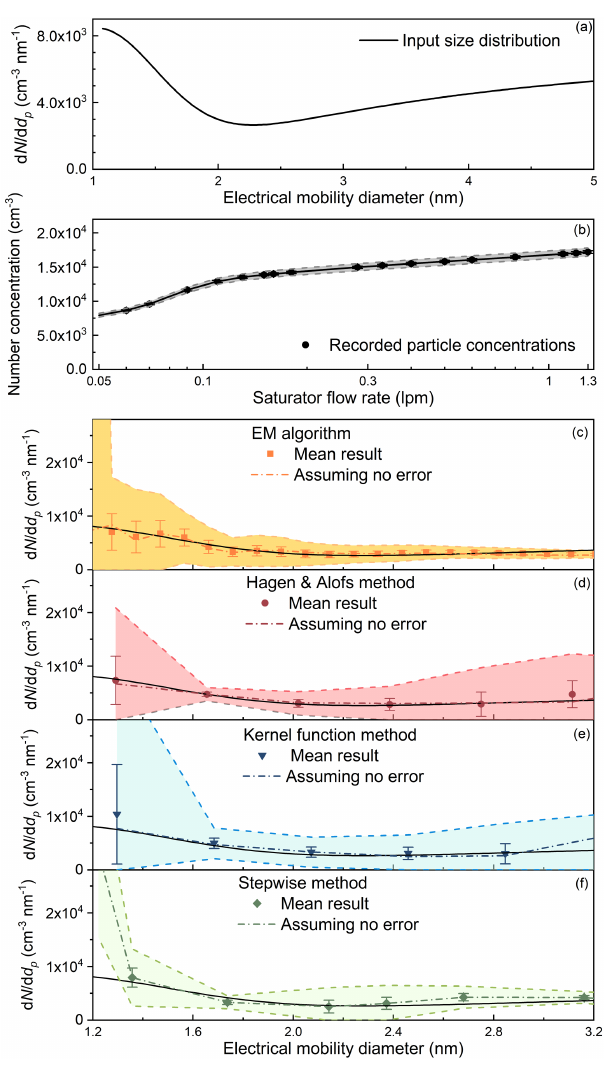
Figure 10. The input and recovered sub-3nm particle size distri- butions simulated using the Monte Carlo method when the particle size distribution increases with decreasing particle diameter.